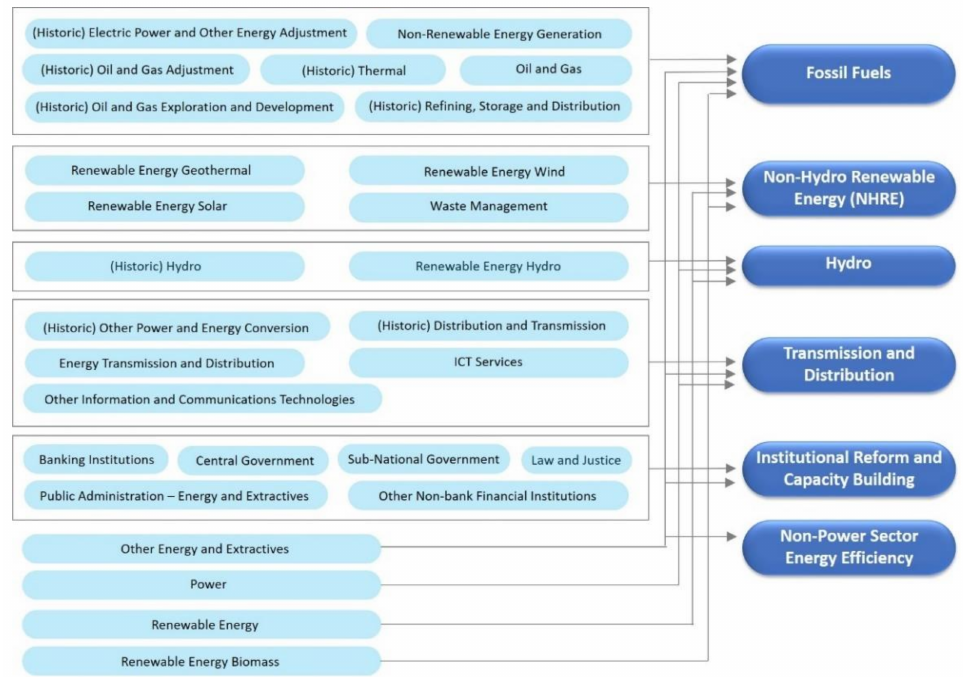
Figure 3. Recategorization of subsectors. Source: authors’ elaboration based on